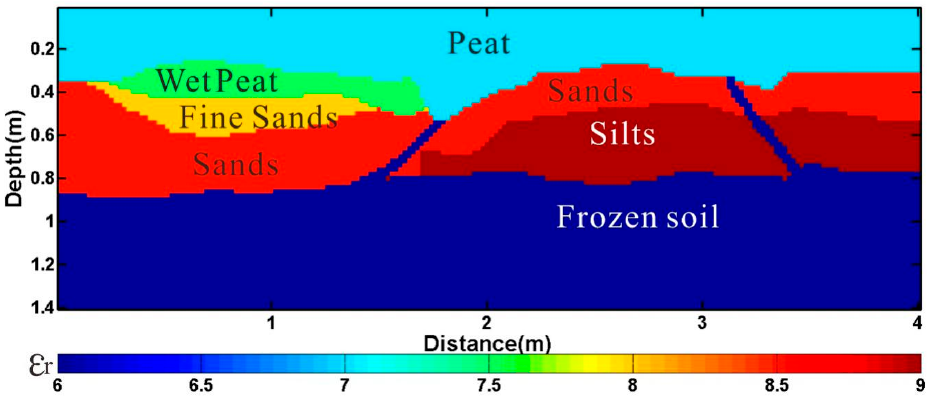
Figure 11. The relative dielectric constant model was designed using the L2 line RTM profile.